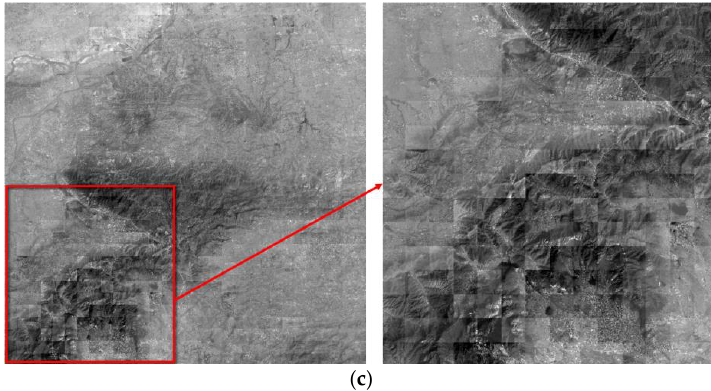
Figure 10. Results based on different sequences: ( a ) result based on left image benchmark; ( b ) result based on above image benchmark; and ( c ) result based on left image cross.